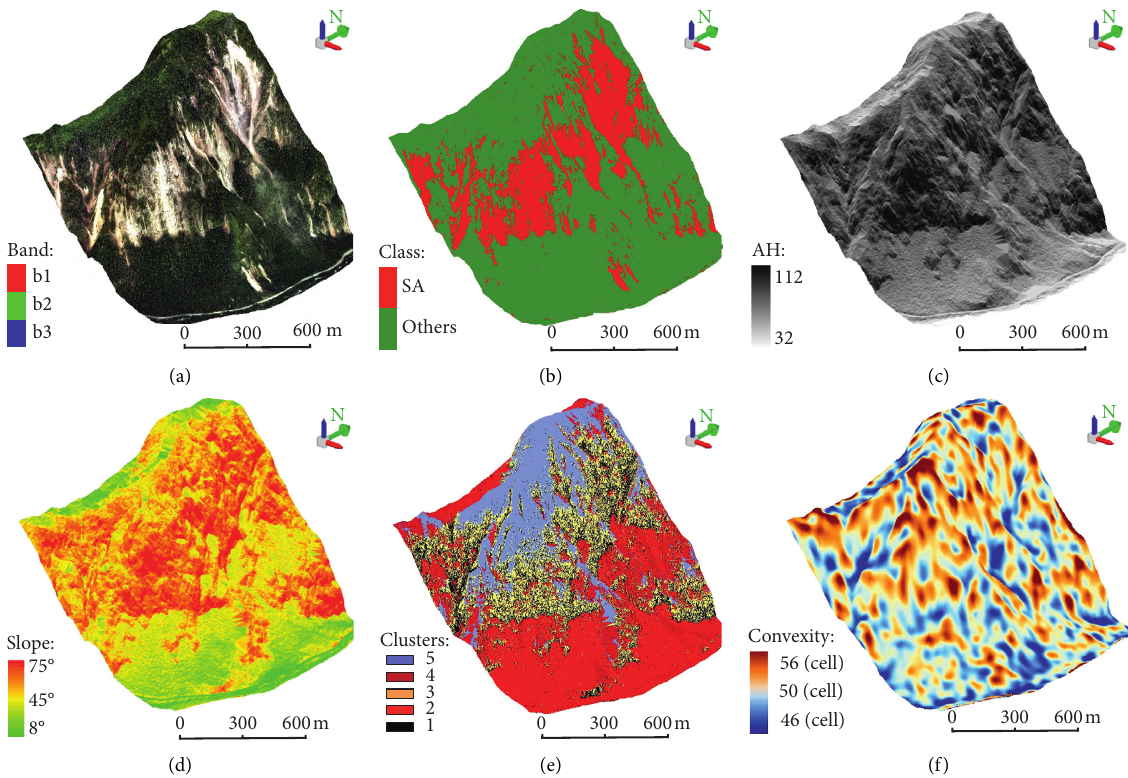
Figure 6: Identification of the source of the material causing rockfall hazards based on digital terrain analysis technology: (a) 3D vi- sualization technology, (b) neural network classification was used to identify the source area of debris, (c) hill-shading map, (d) slope, (e) terrain clustering, and (f) terrain surface